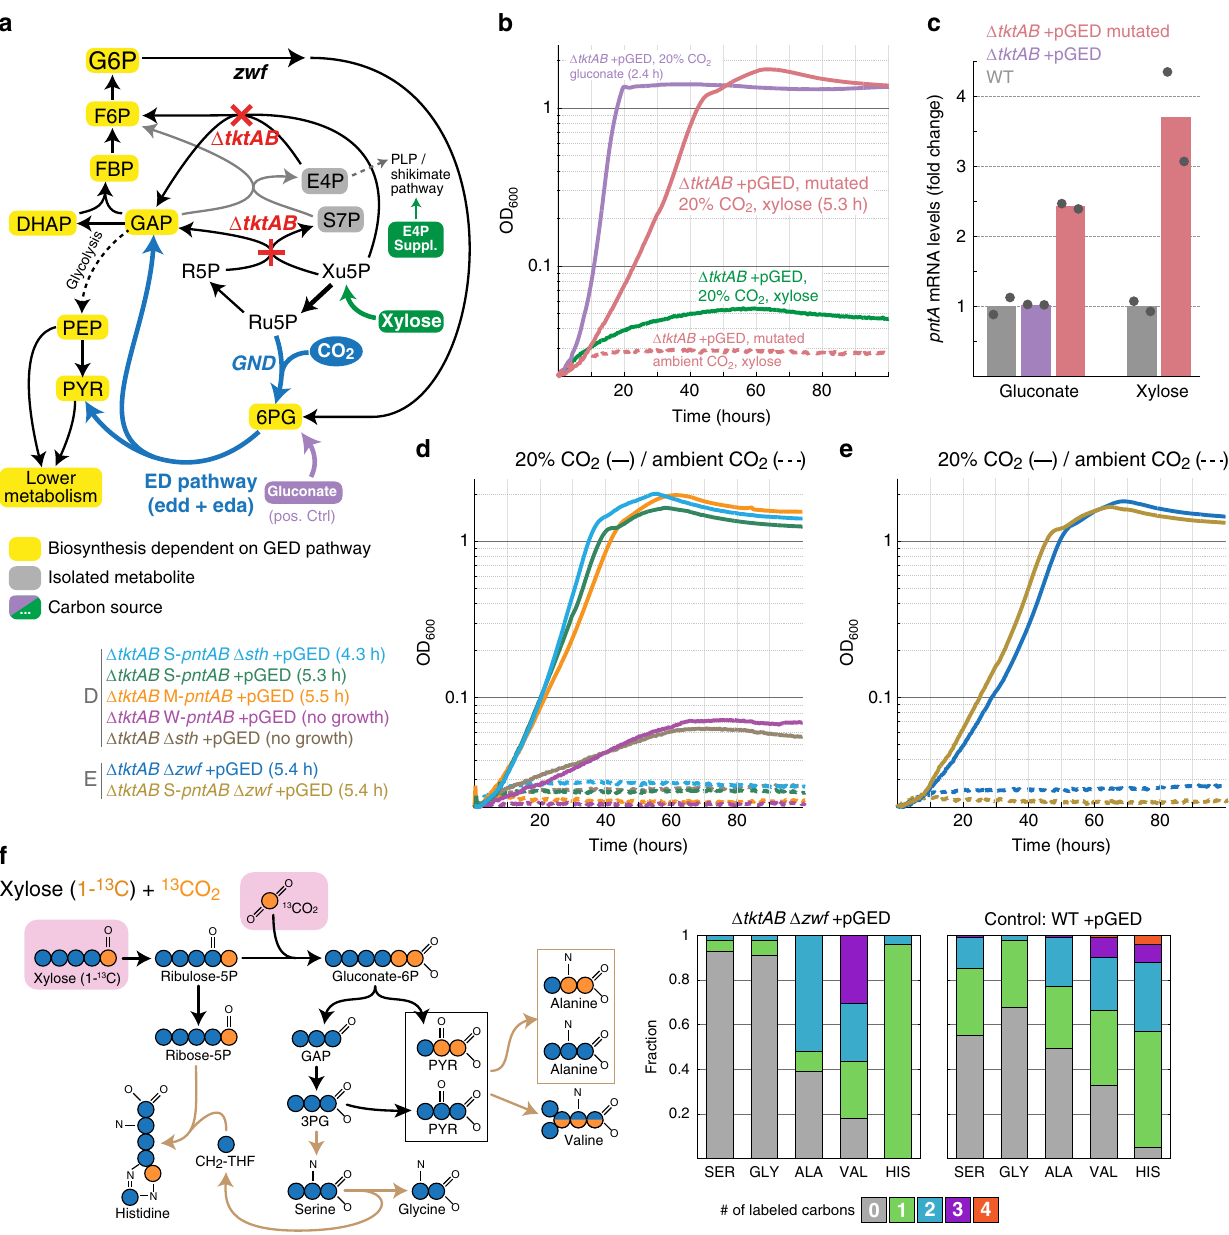
Fig. 3 Activity of the GED shunt in a Δ tktAB strain. a Design of the Δ tktAB selection scheme. Xylose can be assimilated only via the GED shunt. E4P supplements are provided as the Δ tkt AB strain cannot synthesize erythrose 4-phosphate. Growth on gluconate is not dependent on reductive carboxylation by Gnd and thus serves as a positive control. Reaction directionalities are shown as predicted by fl ux balance analysis. b Growth on xylose upon overexpression of gnd , edd , and eda (pGED) was achieved only after mutation and was dependent on elevated CO 2 concentration. Values in parentheses indicate doubling times. Curves represent the average of technical duplicates, which differ from each other by <5%. Growth experiments were repeated independently three times to ensure reproducibility. c Expression analysis by quantitative RT-PCR revealed that the transcript level of pntA increased ~3-fold in the mutated strain. Bars correspond to the average of two independent experiments, which are shown as circles. Gluconate and xylose indicate carbon sources used. d Genomic overexpression of pntAB using medium (M) or strong (S) promoter, but not weak (W) promoter, supported growth of a Δ tkt AB pGED strain on xylose (legend to the left). e Deletion of glucose 6-phosphate dehydrogenase ( Δ zwf ) supported the growth of a Δ tkt AB pGED strain on xylose (legend to the left). f 13 C-labeling experiments con fi rm the operation of the GED shunt. Cells were cultivated with xylose (1- 13 C) and